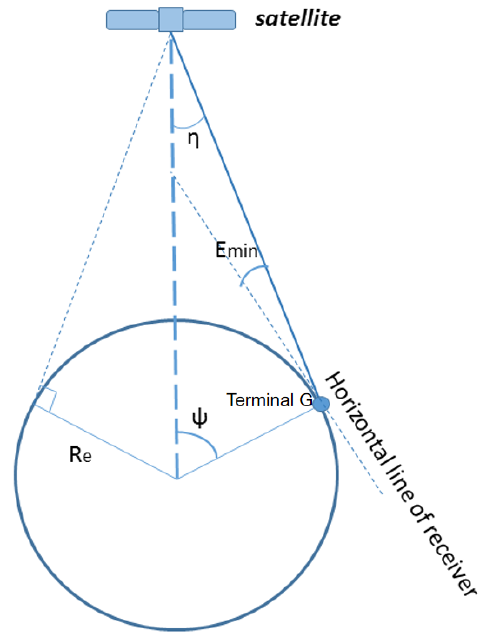
Figure 1. Schematic diagram of satellite coverage angle.